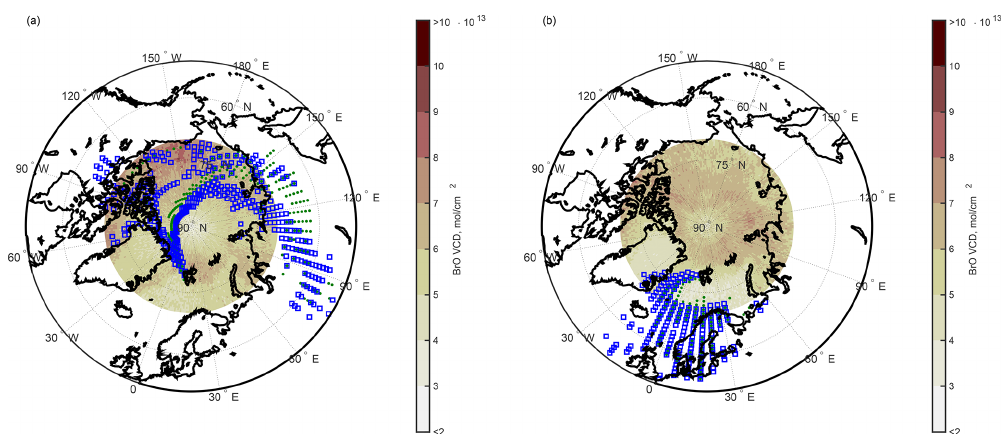
Figure 10. HYSPLIT 10d air mass backward trajectories probability for the strongest O 3 depletion (a) and O 3 increase (b) events detected both in Barentsburg (green dots) and at the Zeppelin station (blue squares). The points show the trajectory probability above the median calculated for the ensemble with 27 trajectories. The 10d mean BrO total VCD for the Arctic region ( > 70 ◦ N) is shown with the colour scale. The percentage of trajectories descending from higher altitudes ( > 2000m) is 1% and 3% for the depletion case (a) and 25% and 14% for the O 3 increase (b) for Zeppelin and Barentsburg,